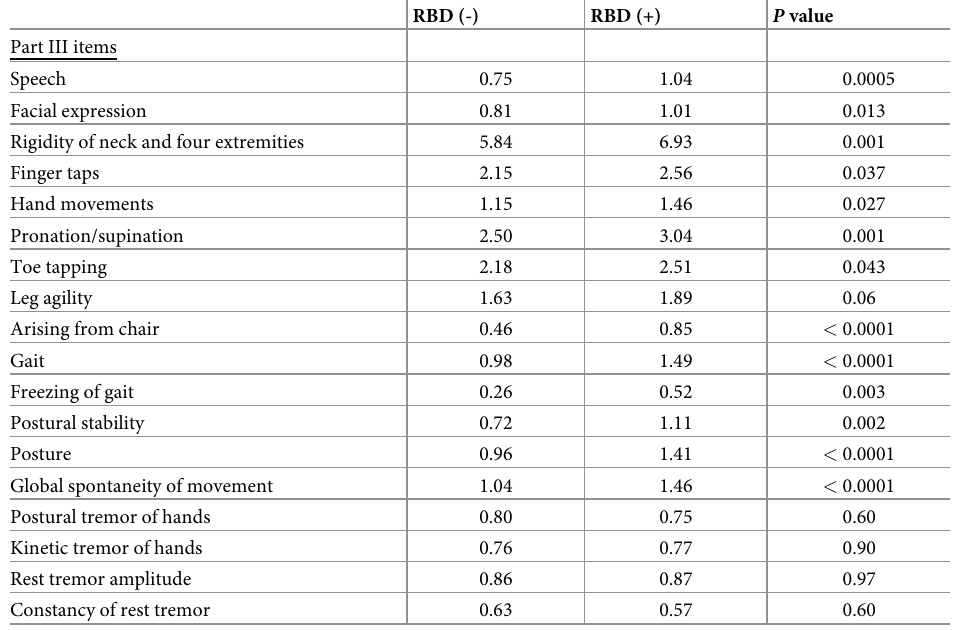
Table 5. Comparison of sub-items on the MDS-UPDRS part III between patients with PD with and without pRBD as evaluated by the Japanese version of the RBD screening questionnaire. RBD (-) RBD (+)